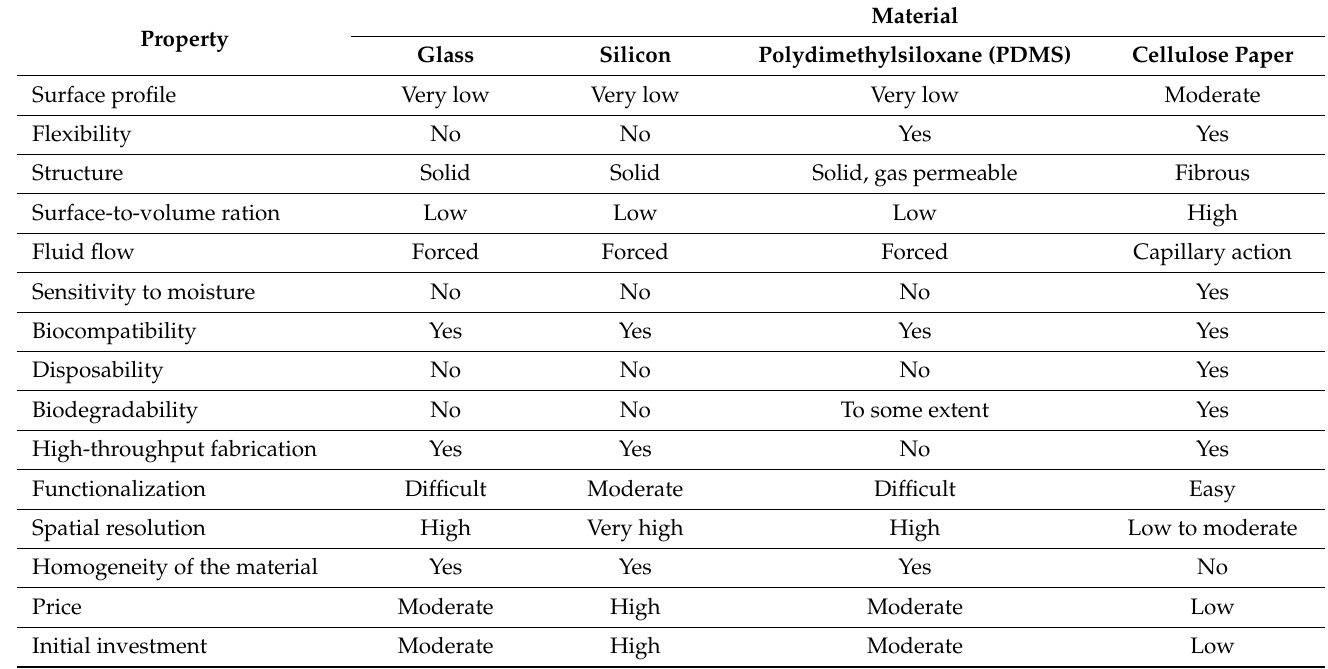
Table 4. Comparison of cellulose paper with traditional materials as